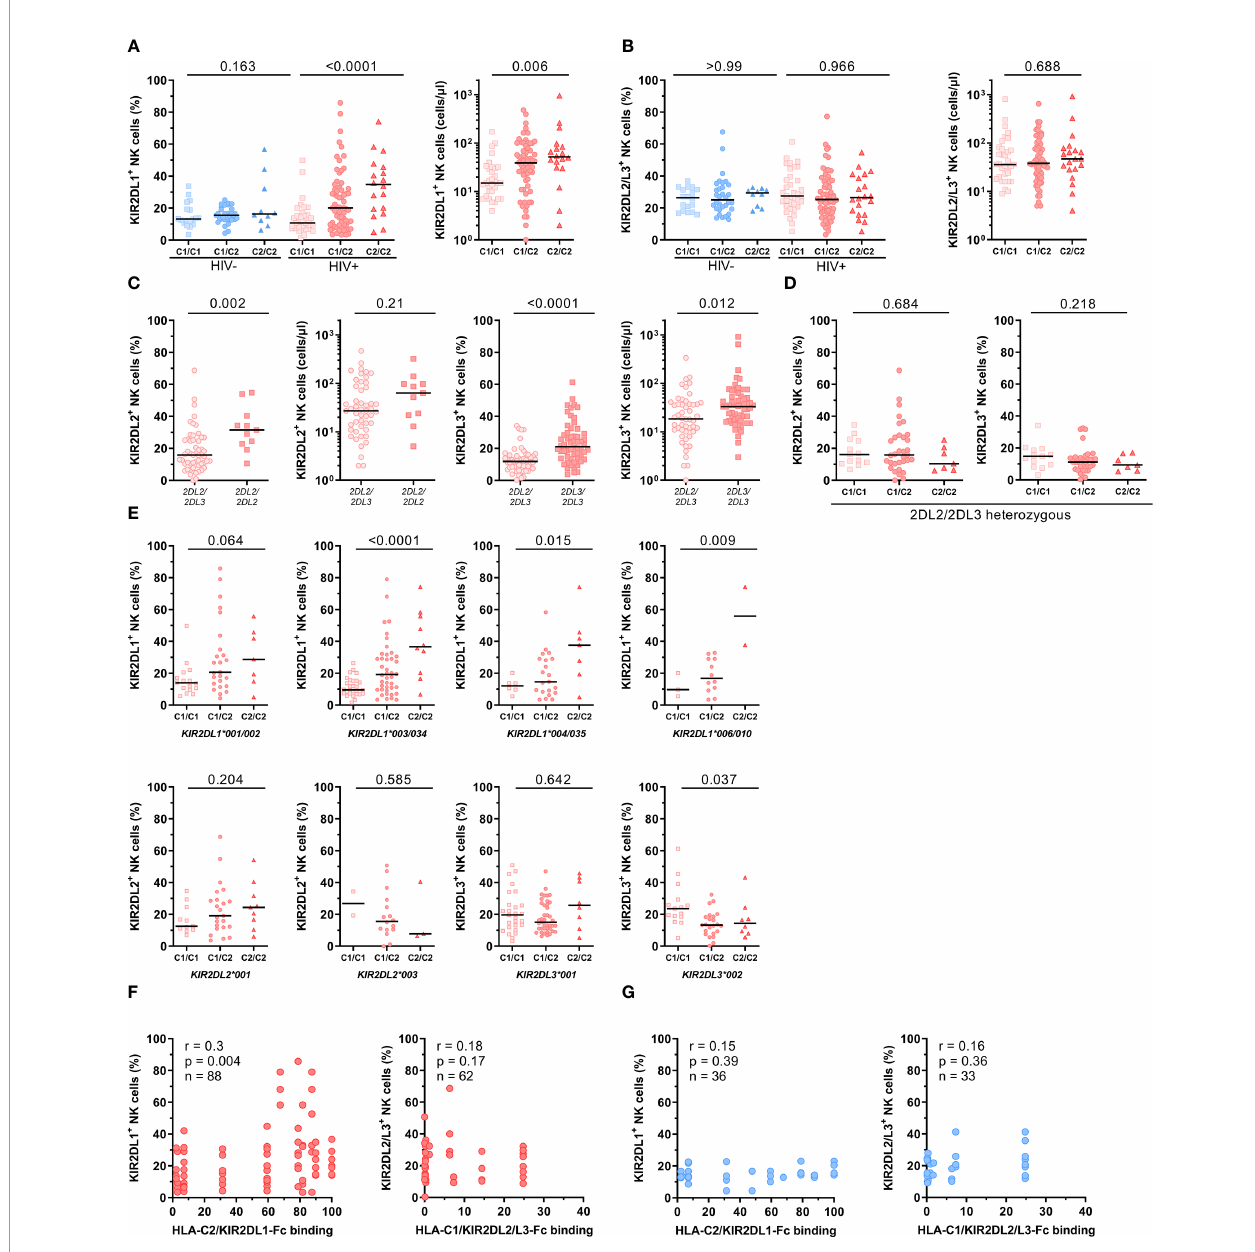
FIGURE 3 | Impact of HLA-C and KIR genotypes on the frequency of NK cells expressing HLA-C-binding KIRs. (A) Percentage of KIR2DL1 + cells within bulk NK cells in HIV-1 - and HIV-1 + individuals (left panel). Absolute numbers of KIR2DL1 + NK cells in HIV-1 + individuals (right panel). (B) Percentage of KIR2DL2/L3 + cells within bulk NK cells in HIV-1 - and HIV-1 + individuals (left panel). Absolute numbers of KIR2DL2/L3 + NK cells in HIV-1 + individuals (right panel). (A/B) Donors were strati fi ed by HLA-C group genotypes. Genotypes were de fi ned by the presence of HLA-C allotypes carrying either a C1 or C2 epitope (C1/C1 = C1 homozygous , C1/C1 = C1/C2 heterozygous , C2/C2 = C2 homozygous ). (C) Percentage and absolute cell numbers of KIR2DL2 + NK cells and KIR2DL3 + NK cells in HIV-1 + individuals strati fi ed by the presence of KIR2DL2 or KIR2DL3 alleles. (D) Percentage of KIR2DL2 + and KIR2DL3 + NK cells in KIR2DL2/L3 heterozygous HIV-1 + individuals strati fi ed by HLA-C group genotypes. (E) Percentage of KIR2DL1 + , KIR2DL2 + and KIR2DL3 + NK cells in HIV-1 + individuals strati fi ed by HLA-C group genotypes and KIR2DL alleles. (F) Correlation between percentage of KIR2DL1 + NK cells and HLA-C2/KIR2DL1-Fc binding, KIR2DL2/L3 + NK cells and HLA-C1/KIR2DL2/L3-Fc binding in HIV-1 + individuals (red) strati fi ed by KIR/HLA binding af fi nities determined in Figure 1 . (G) Correlation between percentage of KIR2DL1 + NK cells and HLA-C2/KIR2DL1-Fc binding, KIR2DL2/L3 + NK cells and HLA-C1/KIR2DL2/L3-Fc binding in HIV-1 - individuals (blue) strati fi ed by KIR/HLA binding af fi nities determined in Figure 1. Data information: Black bars display the median. (A, B, D, E) One-way ANOVA, test for linear trend. (C) Mann-Whitney test. P values were adjusted for multiple comparisons ( A, B, D: Bonferroni; E : Benjamini/Krieger/Yekutieli). (F, G) Spearman rank